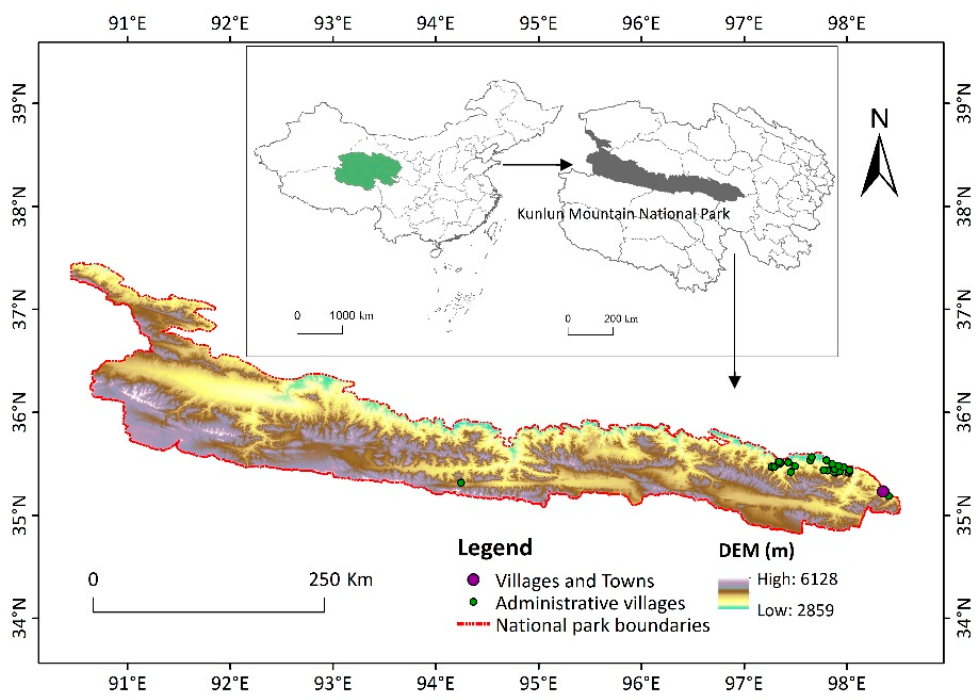
Figure 1. The geographic location of the study area.